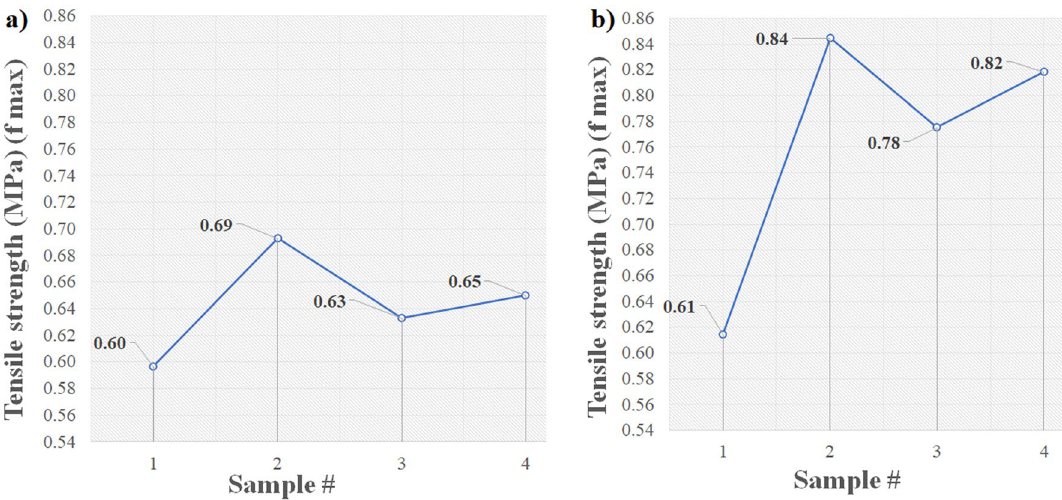
Figure 14. Tensile strength ( a ) after 14 days ( b ) after 28